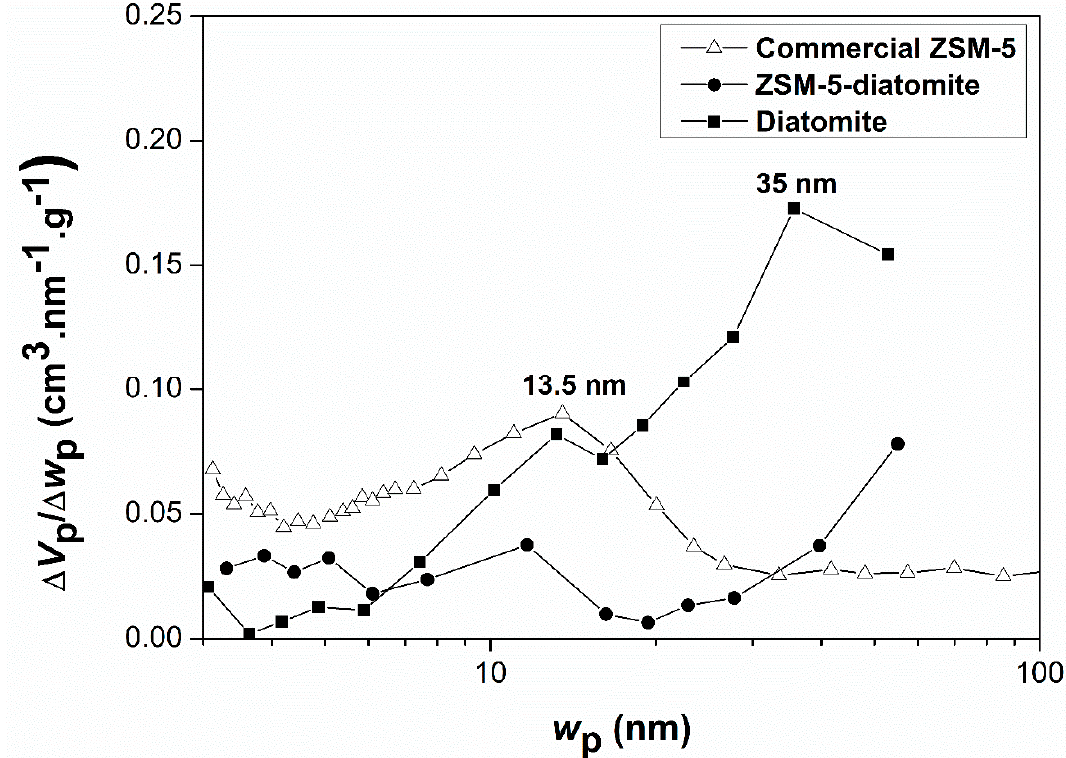
Figure 6. Mesopore-size distribution of the different materials calculated by the Villarroel-Barrera-Sapag (VBS) method using the adsorption branch data of the nitrogen isotherm.